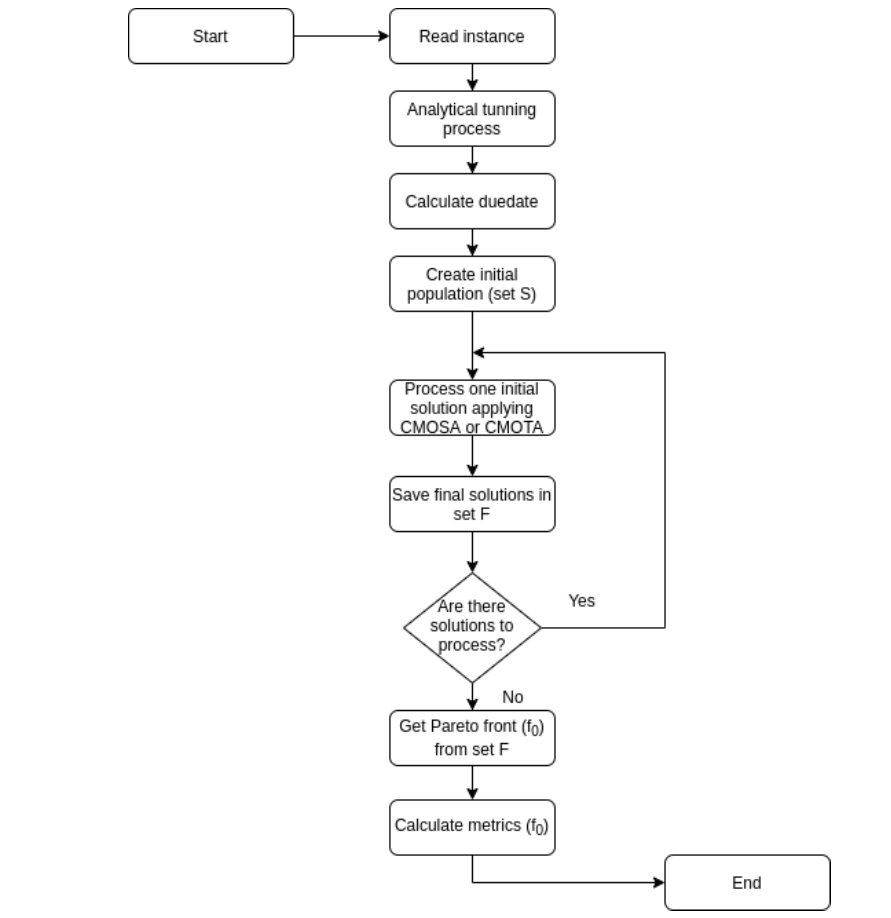
Figure 1. Main module for CMOSA and CMOTA.